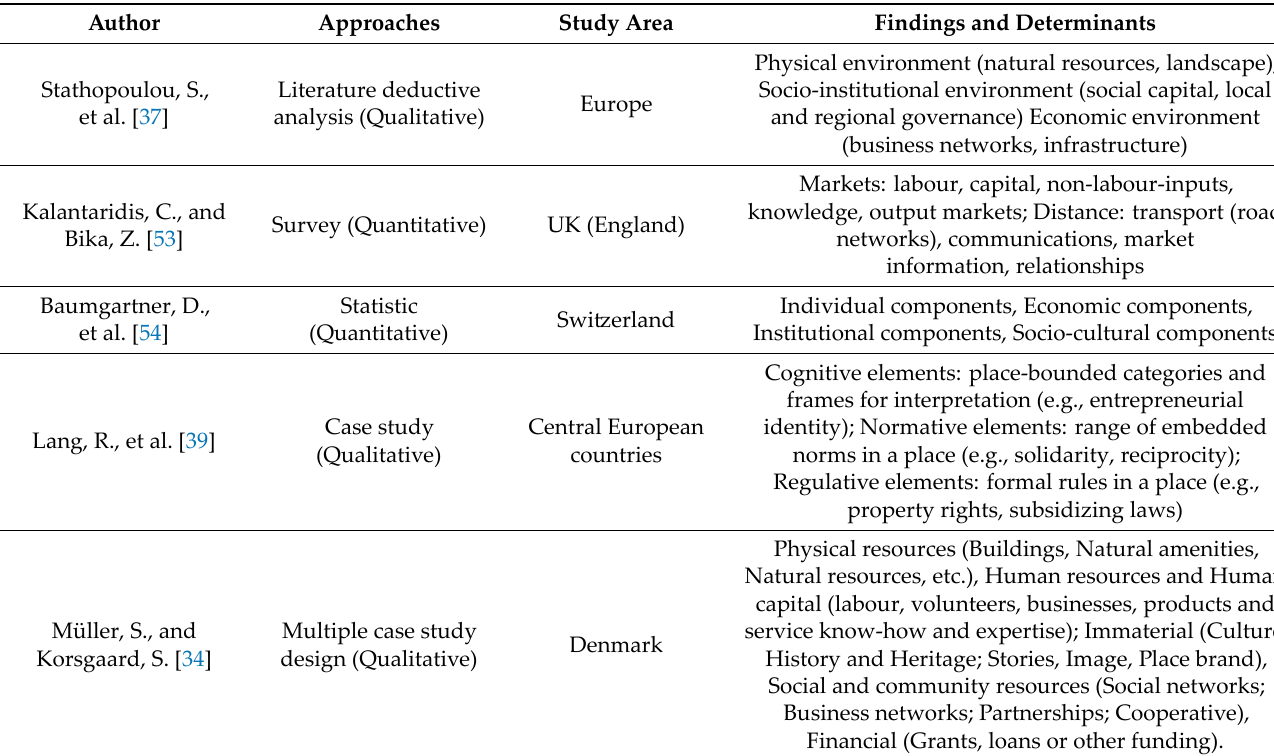
Table 1. Context measurements in rural entrepreneurship